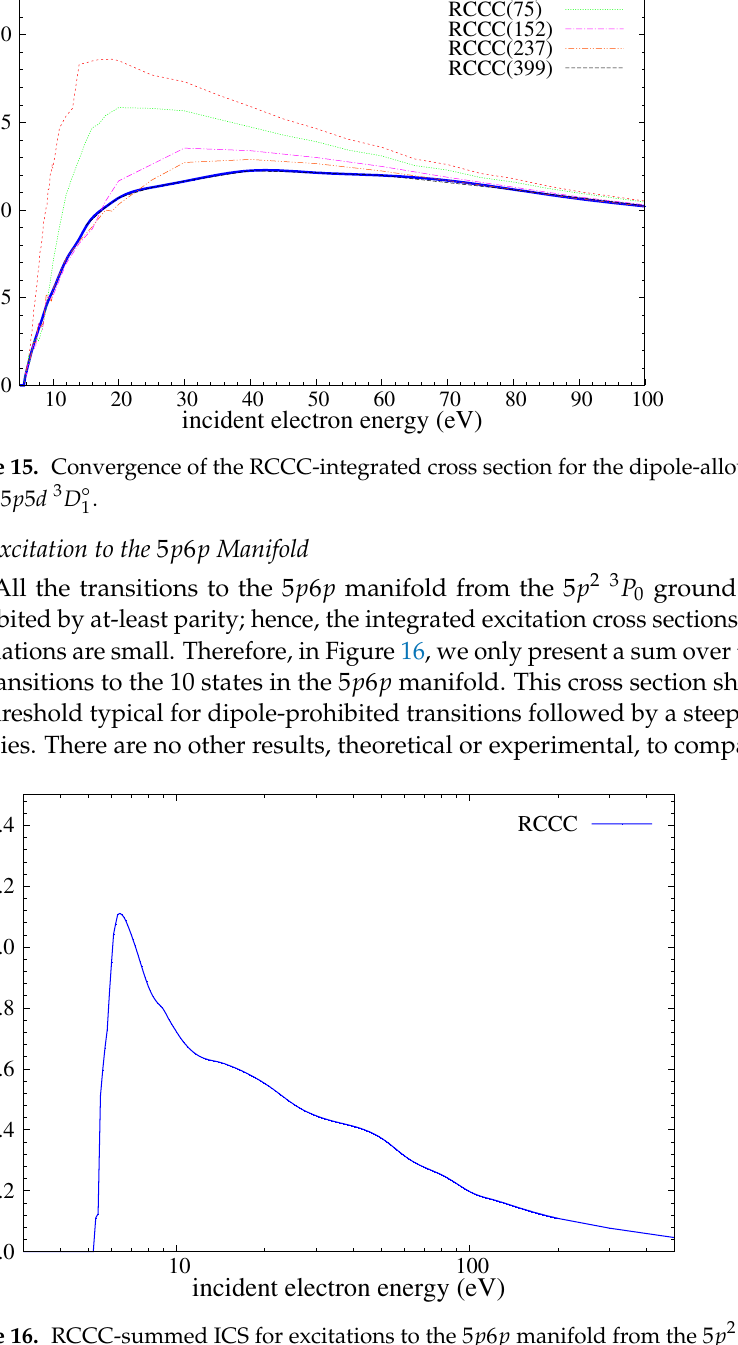
Figure 16. RCCC-summed ICS for excitations to the 5 p 6 p manifold from the 5 p 2 3 P 0 ground